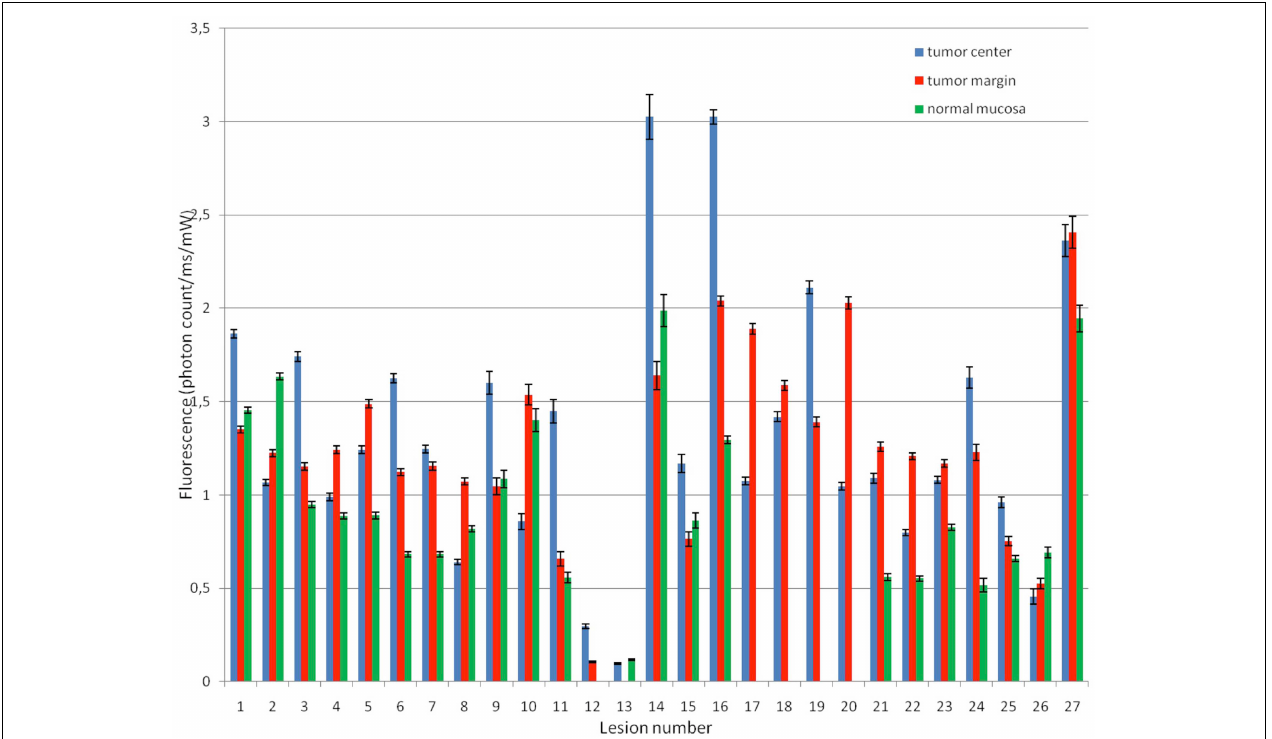
FIGURE 3 | Fluorescence attributable to mTHPC at tumor center, margin, and normal mucosa before PDT in all measured lesions. TC had average 1.50 times more fluorescence than NM but with a high standard deviation (0.66). It can be seen that in some cases NM has more fluorescence than TC.